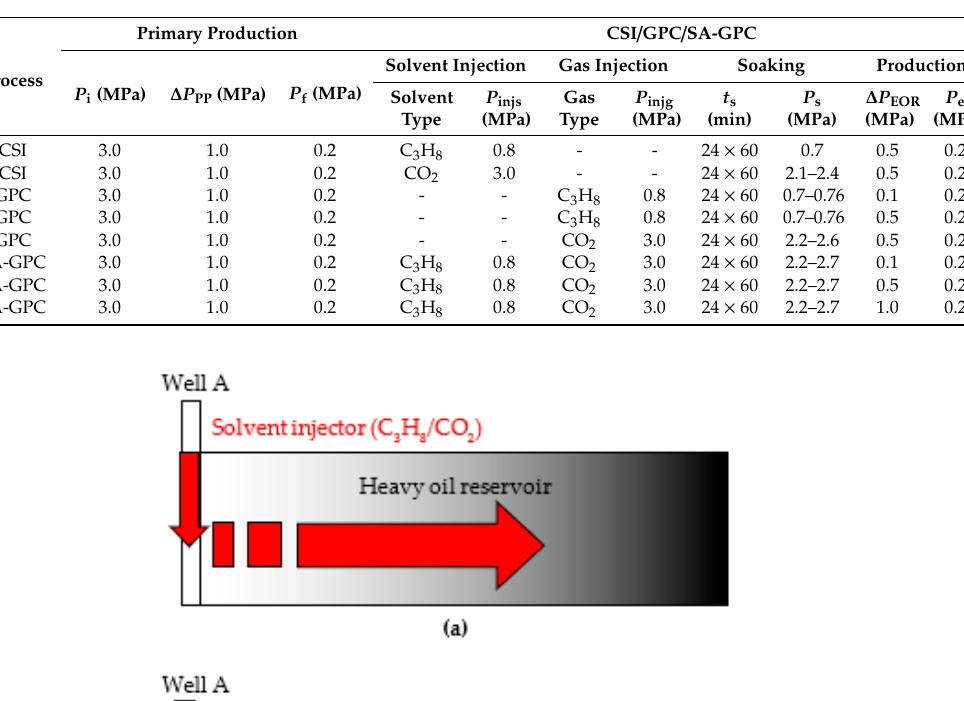
Table 2. Technical details of Tests #1 ‒ 8 (including the primary production) at T res = 21.0 °C. Test No.